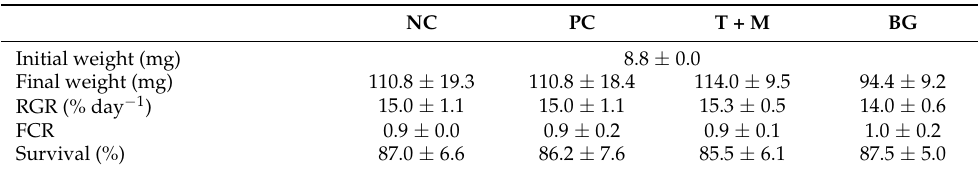
Table 4. Initial and final weight, relative growth rate (RGR), feed conversation ratio (FCR), and survival of whiteleg shrimp ( P. vannamei ) PL during the experimental period.